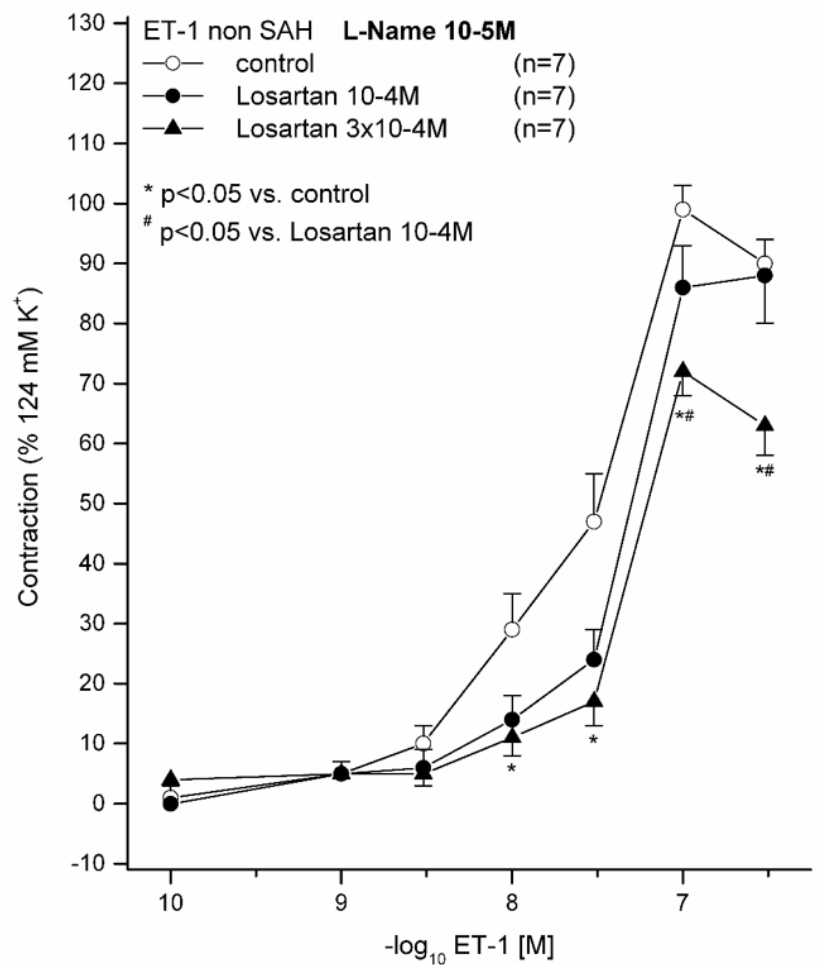
Figure 1. Effect of L-NAME and losartan (LOS) on ET-1-induced contraction in basilar artery ring segments in the sham group. ET-1 induced a dose-dependent contraction. Displayed are the concentration–effect curves (CECs) for each group (with and without LOS). LOS reduced the E max dose-dependently. For subarachnoid haemorrhage (SAH) with 3 × 10 − 4 M LOS, a statistically significant reduction of E max was calculated. * p < 0.05 versus without LOS; # p < 0.05 versus 10 − 4 M